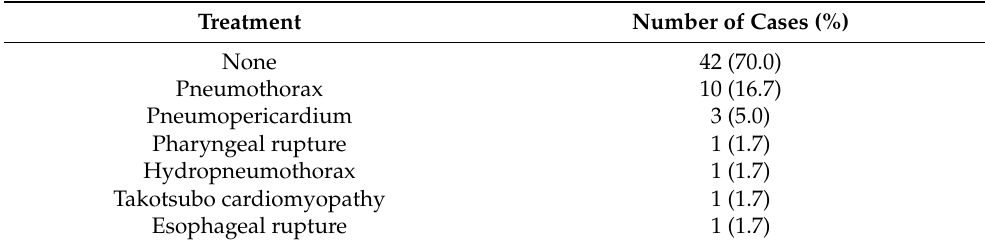
Table 5. Complications associated with SPM (Total cases = 60, Not reported =